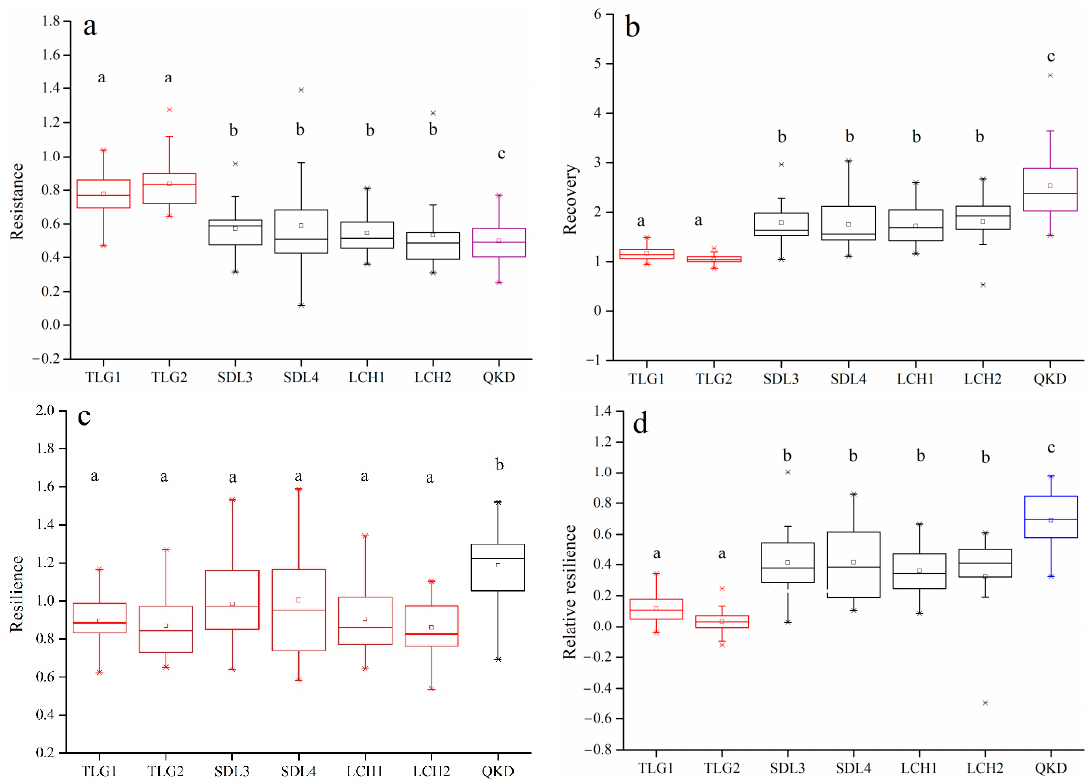
Figure 5. The regional differences in stable indices (( a ): Resistance; ( b ): Recovery; ( c ): Resilience, ( d ): Relative resilience) indicated by ANOVA analysis. The different letters above the boxes indicate significant differences between the two boxes, the same letter indicates insignificant difference. TLG1, TLG2, SDL3, SDL4, LCH1, LCH2, and QKD refer to the different sampling sites shown in Table 1.